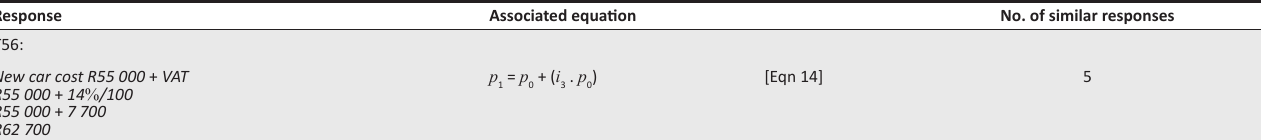
TABLE 5: Response illustrating other